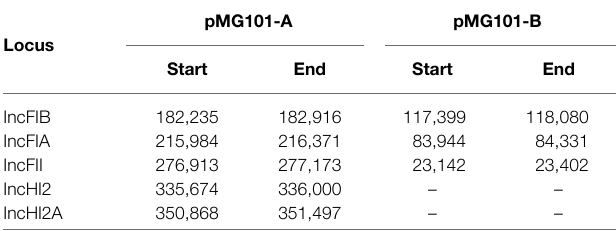
TABLE 1 | Plasmid replicon typing of pMG101-A and pMG101-B.